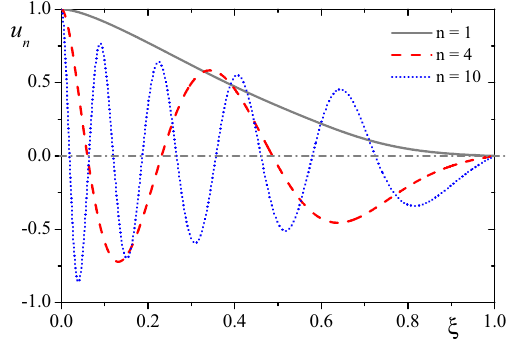
Fig. 3 The first, fourth and tenth eigen states for the same